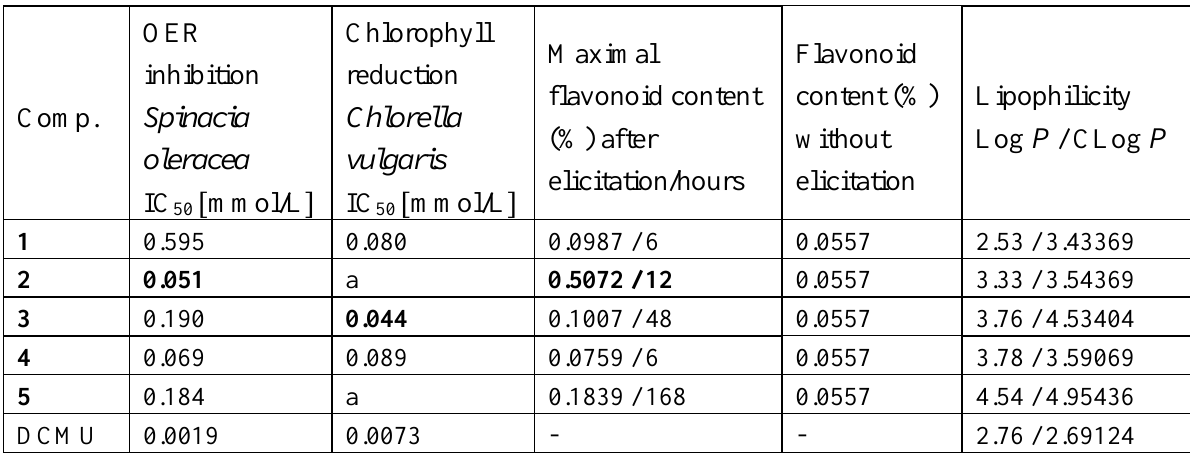
Table 1. Oxygen evolution rate (OER) inhibition in spinach chloroplasts (IC ), reduction of 50 chlorophyll content in C. vulgaris (IC ), maximal flavonoid content (% / hours) after 50 elicitation and without elicitation (%), and calculated lipophilicity (log P , Clog P ) of compounds 1 - 5 in comparison with the herbicide diurone